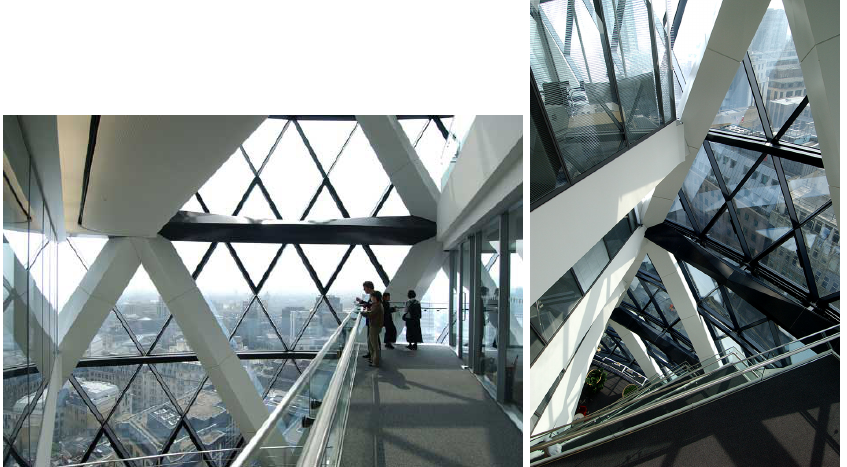
Figure 9. Swiss Re Tower—Interior Atrium (Courtesy Nigel Young/Foster +